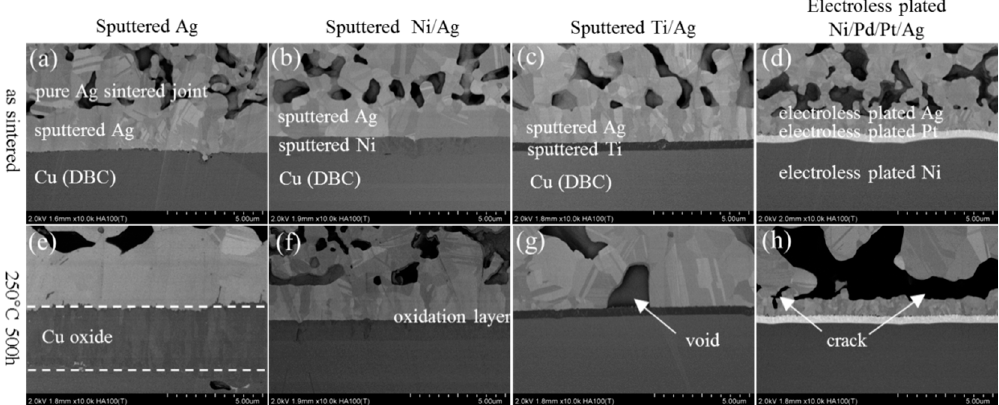
Figure 5. Evolution of a pure Ag sintered joint with various substrates in as-sintered state and after HTS for 500 h: ( a – d ) as sintered state, ( e – h ) after HST for 500 h.